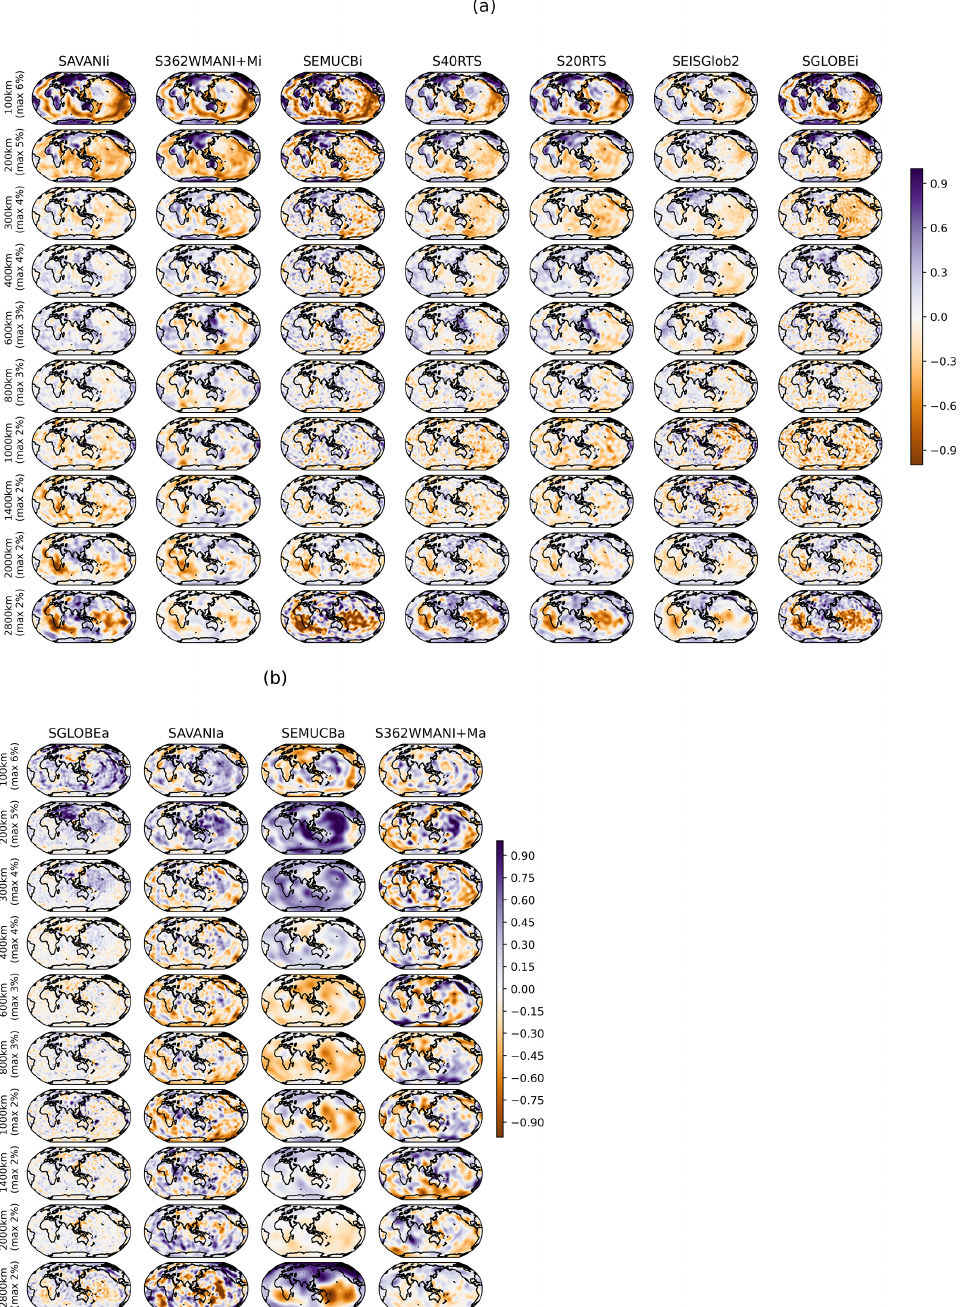
/V 2 with respect to SH SV